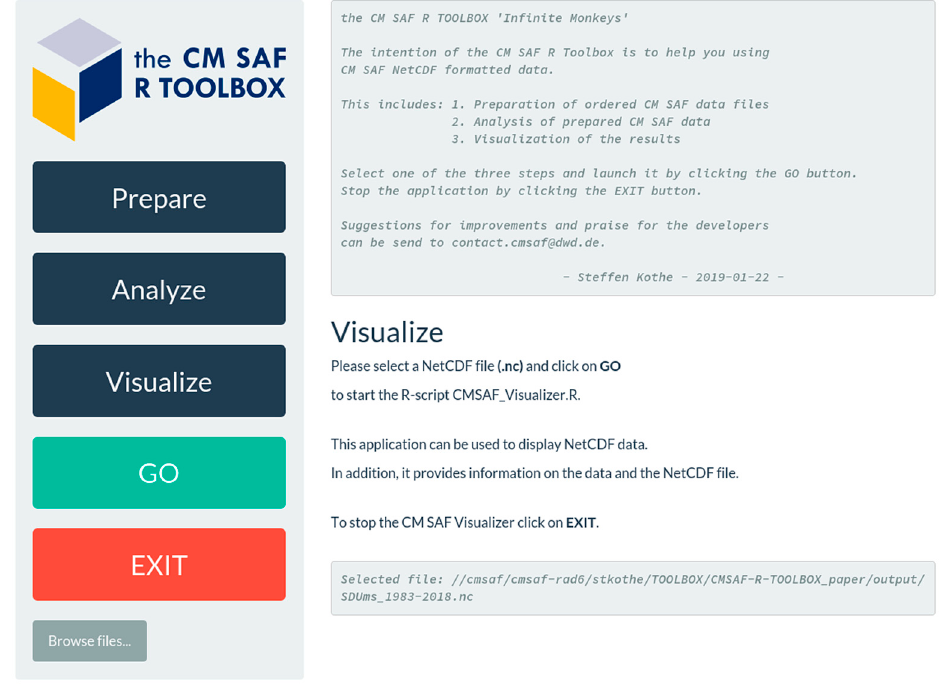
Figure 3. Main user interface of the CM SAF R Toolbox.